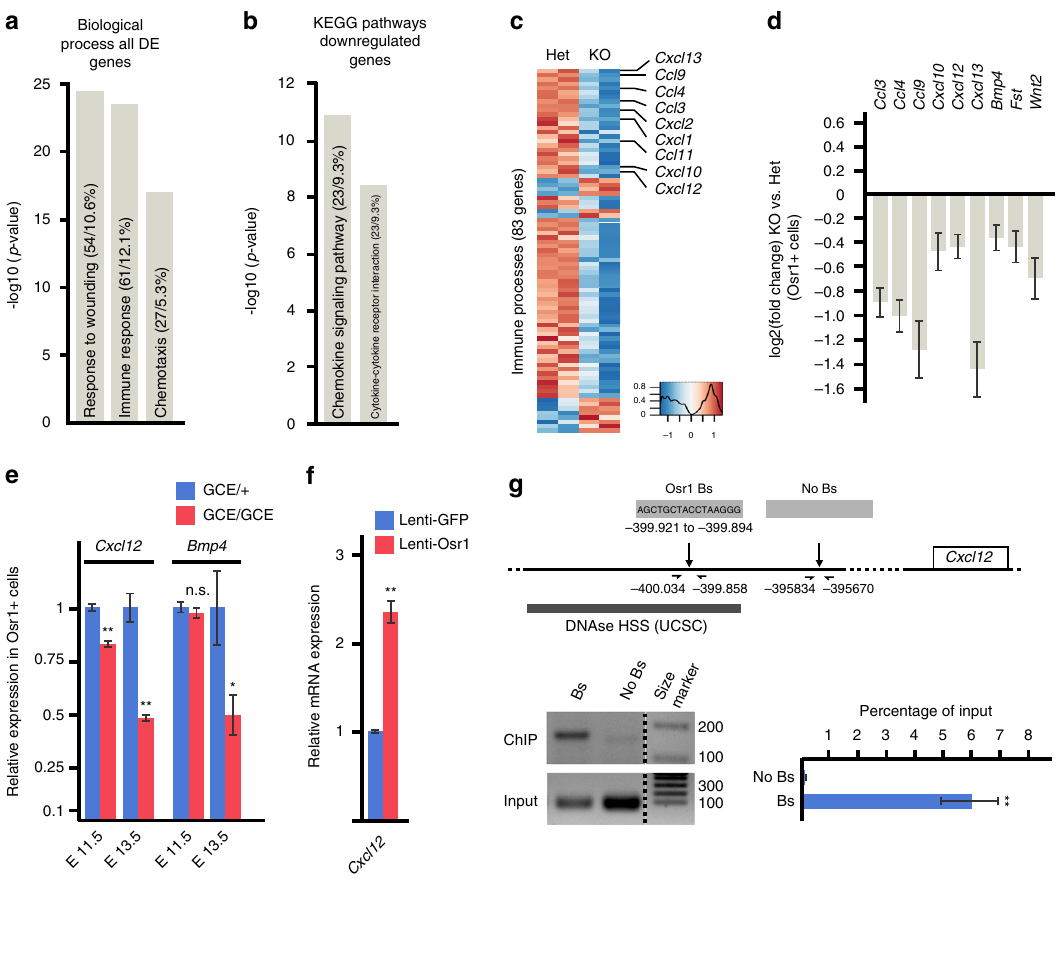
Fig. 8 Osr1 cells are a source or growth factor signalling and Osr1 directly controls Cxcl12 expression. a Gene ontology (GO) analysis for “ biological process ” using all deregulated (DE) genes ( Osr1 GCE/ + vs. Osr1 GCE/GCE cells) showed signi fi cant enrichment for the indicated terms. b KEGG pathway analysis of downregulated genes. c Heatmap depiction of all non-redundant DE genes contained in the GO terms shown in c collectively termed “ immune processes ” . Several genes for signalling molecules from chemokine families appear downregulated in Osr1 GCE/GCE limb cells. d Deregulation of secreted signalling molecules selected from all DE genes for their previously demonstrated role in myogenesis. e Con fi rmation of downregulation of Cxcl12 and Bmp4 in Osr1 - de fi cient cells isolated at E11.5 and E13.5 by RT-qPCR ( n = 5). f Upregulation of Cxcl12 upon lentiviral Osr1 overexpression. g Chromatin immunoprecipitation (ChIP) for a putative Cxcl12 enhancer. Representative gel pictures of ChIP vs. input are shown below schematic representation of the locus, con fi rmation of binding site pulldown via RT-qPCR ( n = 3) shown right. Bs: putative binding site, No Bs: control region. DNAse HSS: DNAseI hypersensitive regions according to UCSC. Size marker: 100 base pair ladder; band sizes are indicated in base pairs. Error bars represent log2 fold change standard error (ifcSE) estimated by DESeq2 in d and s.e.m. in e , f , g . T-test: * = p < 0.05; ** = p < 0.01. N-numbers indicate biological replicates, i.e. samples from different specimen in e or independent assays in f , key transcription factor that maintains embryonic Osr1 + FAP cell identity. Loss of Osr1 in turn leads to a shift in embryonic FAP transcriptional activity from an ECM characteristic for MCT to cartilage/tendon ECM.